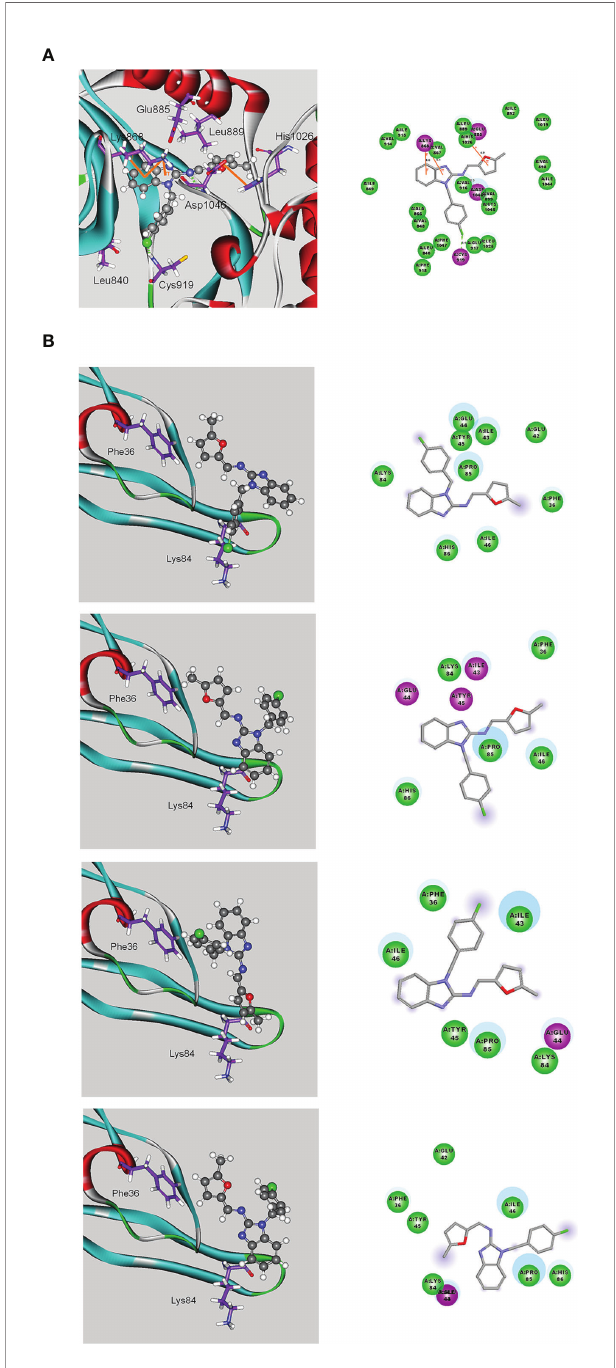
FIGURE 6 | Molecular docking simulation analysis of MFB. (A) Molecular modeling of the interactions between MFB and VEGFR-2. The graph shows the docking pose of VEGFR-2 with MFB (left panel). The docking pose of VEGFR-2 with MFB using a 2D ligand-protein interaction diagram is shown in the right panel. Orange represents p -cation interactions (B) Molecular modeling of the interactions between MFB and VEGF-A. The graph shows the docking pose of VEGF-A with MFB (left panel). The docking pose of VEGF-A with MFB using 2D ligand-protein interaction diagrams is shown in the right